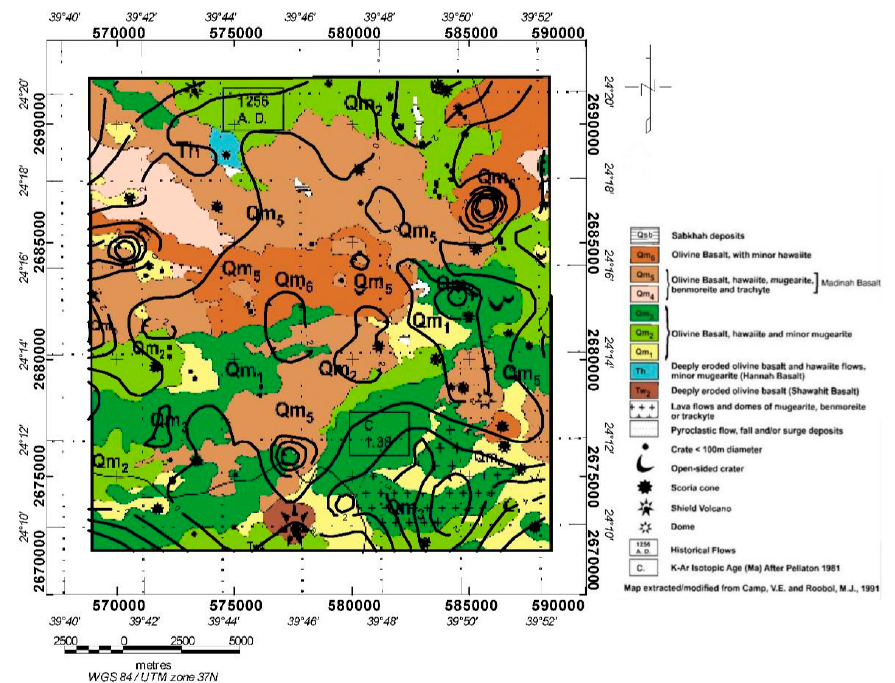
Figure 6. The residual gravity anomalies are superimposed on the surface geology map of the study area. A unique anomaly feature with negative gravity lows recognized in Figure 5 is traced to the geologic region with olivine basalts (Qm1, Qm3, Qm5, and Qm6) within the central part of the study area. The existence of this anomaly feature makes this region desirable for further evalua ‐ tions.